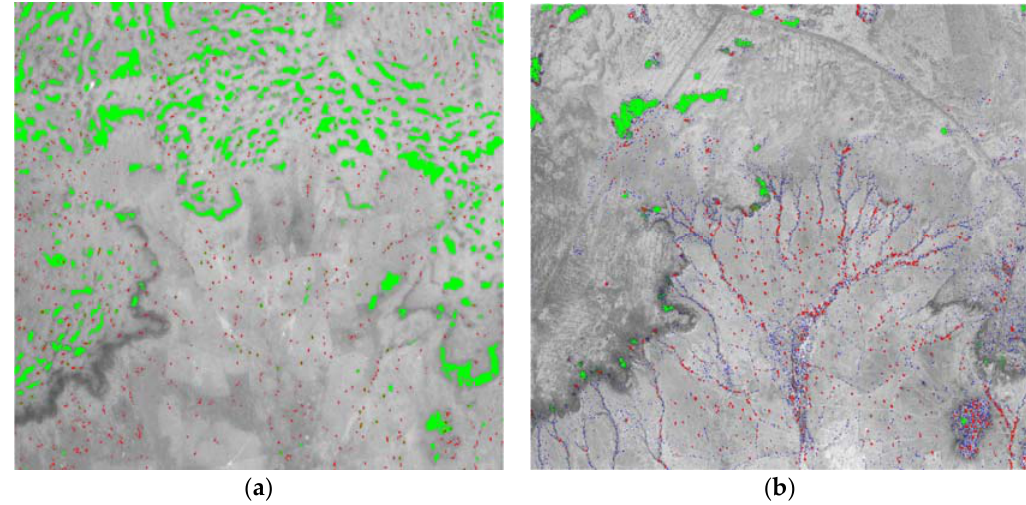
Figure 15. ( a ) Classification in 3 classes after successive nested classifications. Three hundred five patches of tiger bush (green class) and 1885 small spots (red class). Kirib Kaina, 1975; ( b ) Classification in 4 classes. Forty patches of tiger bush (green class), 1402 large spots (red class) and 9978 small spots (blue class). Kirib Kaina, 2011.